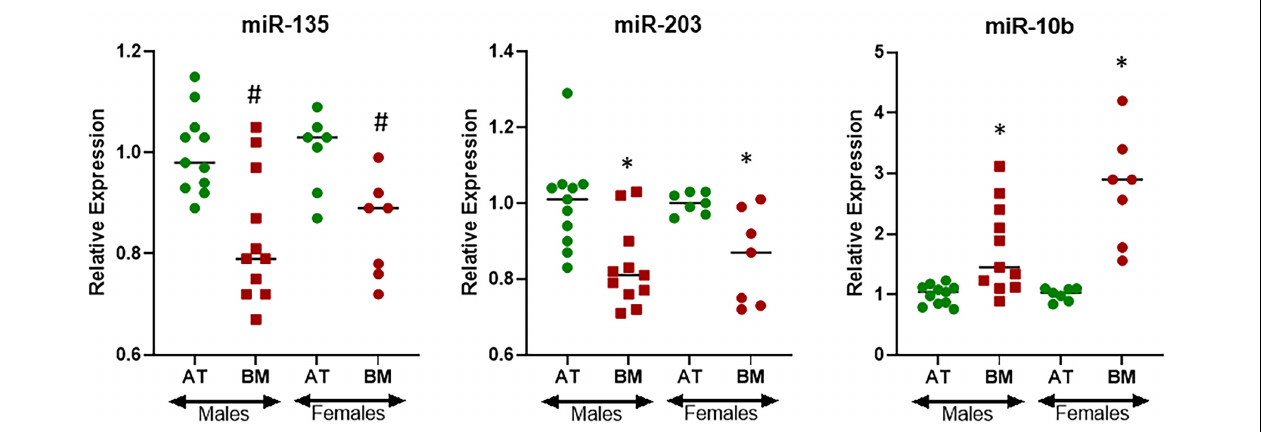
TABLE 2 | Impact of surgical intervention on disease outcome, based on miRNA signature. Group Primary 6 months survival 12 months survival miR-203-Low miR-10b-High (high risk) Surgery 8/10 (80%) 4/10 (40%) No surgery 7/10 (70%) 1/10 (10%) miR-203-High miR-10b-Low (low risk) Surgery 9/10 (90%) 8/10 (80%) No surgery 9/10 (90%) 7/10 (70%) miR-203-Low/miR-10b-High: Patients with low expression of miR-135 and miR-203 and high expression of miR-10b in bone metastasis prior to surgery; miR-203- High/miR-10b-Low: Patients with high expression of miR-135 and miR-203 and low expression of miR-10b in bone metastasis prior to